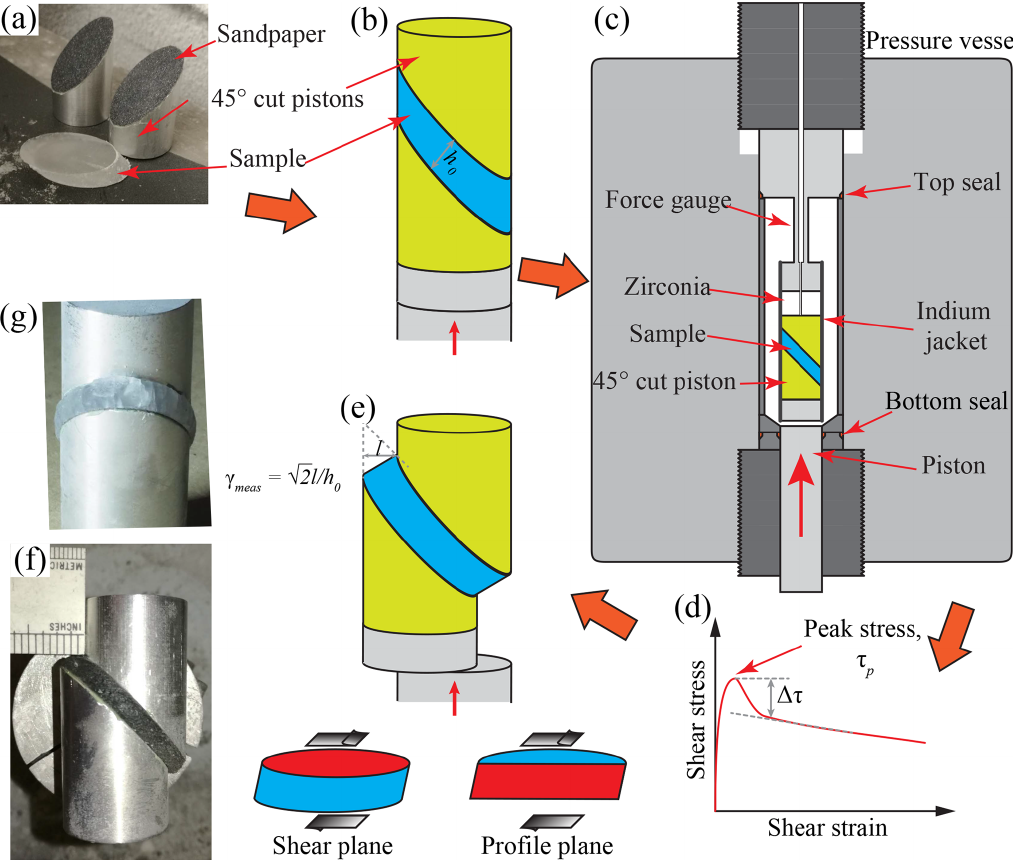
Figure 1. Figures illustrating the experimental procedure. Orange arrows indicate steps. (a) Photo of a sample and aluminum pistons. (b) Schematic drawing of the sample assembly before deformation. (c) Schematic drawing of the pressure vessel and the deformation assembly. (d) Schematic plot of a typical shear stress–shear strain curve during an experiment. Peak stress, τ p , and stress drop, (cid:49)τ , are marked on the curve. (e) Schematic drawing of the sample assembly after deformation. The two sub-drawings at the bottom denote the shear plane and the profile plane (in red). (f, g) Photos of deformed samples at different